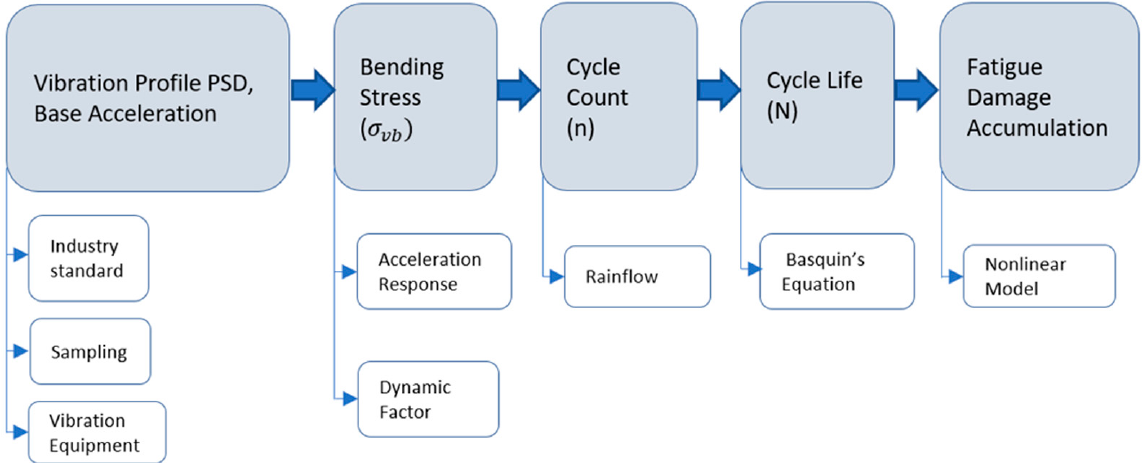
Figure 4. Process for estimating cumulative fatigue damage by random vibration